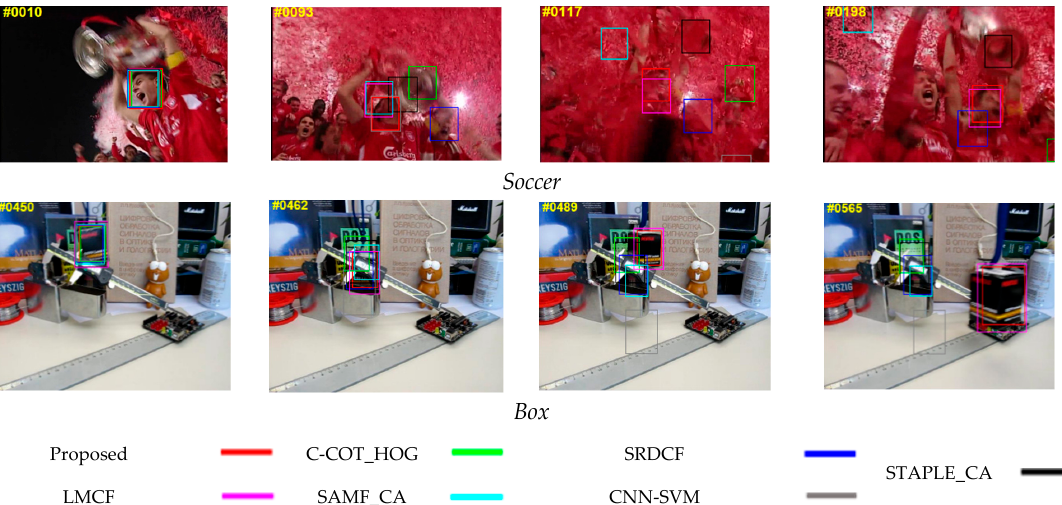
Figure 6. A qualitative comparison of our approach with six trackers, C-COT_HOG [23], SRDCF [21], STAPLE_CA [13], LMCF [22], SAMF_CA [13], CNN-SVM [44]. Tracking results are shown on five video sequences from the OTB dataset (from top to down are Bird2, Dragon Baby, Ironman, Soccer, Box ). Our approach performs favorably compared to the existing tracker in these challenging situations.